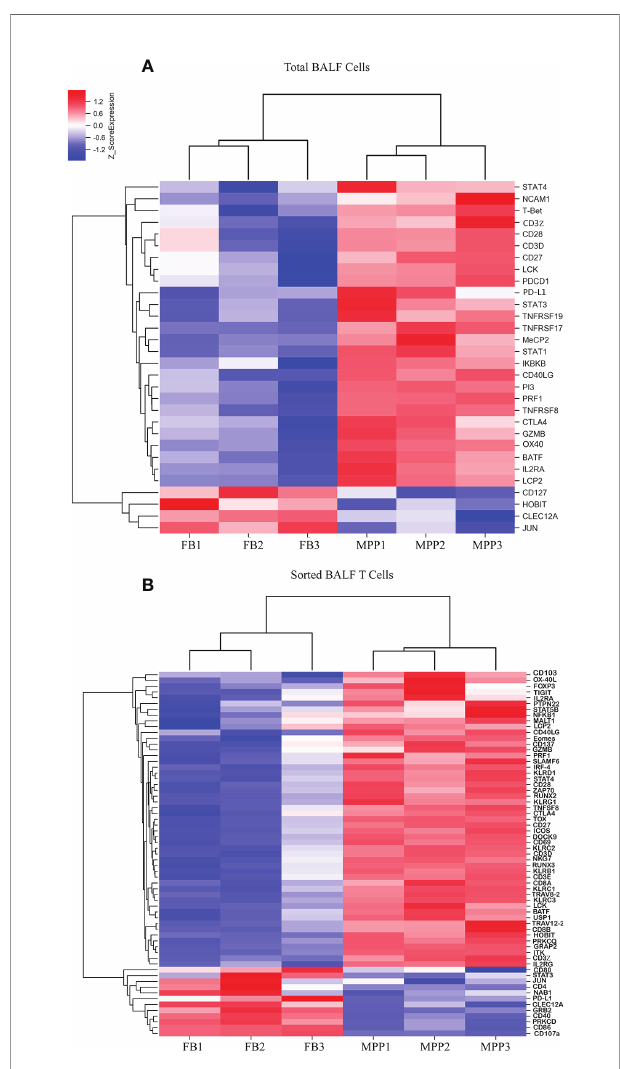
FIGURE 7 | DEGs of T-cell activation and exhaustion derived from microarray data are represented as heat maps. Colors indicate relative expression levels. The gradient color from red to blue means expression of the listed gene from upregulation to downregulation. Gene names of DEGs are listed on the right. Similar pattern of expression are clustered closer with linked line. (A) The heat map for DEGs of T-cell activation and exhaustion gene in BALF cells. Each sample represents BALF cells from an individual patient or FB control. (B) The heat map for DEGs of T-cell activation and exhaustion in sorted CD3+ T cells. Each sample represents sorted CD3+ T cells from an individual patient or FB